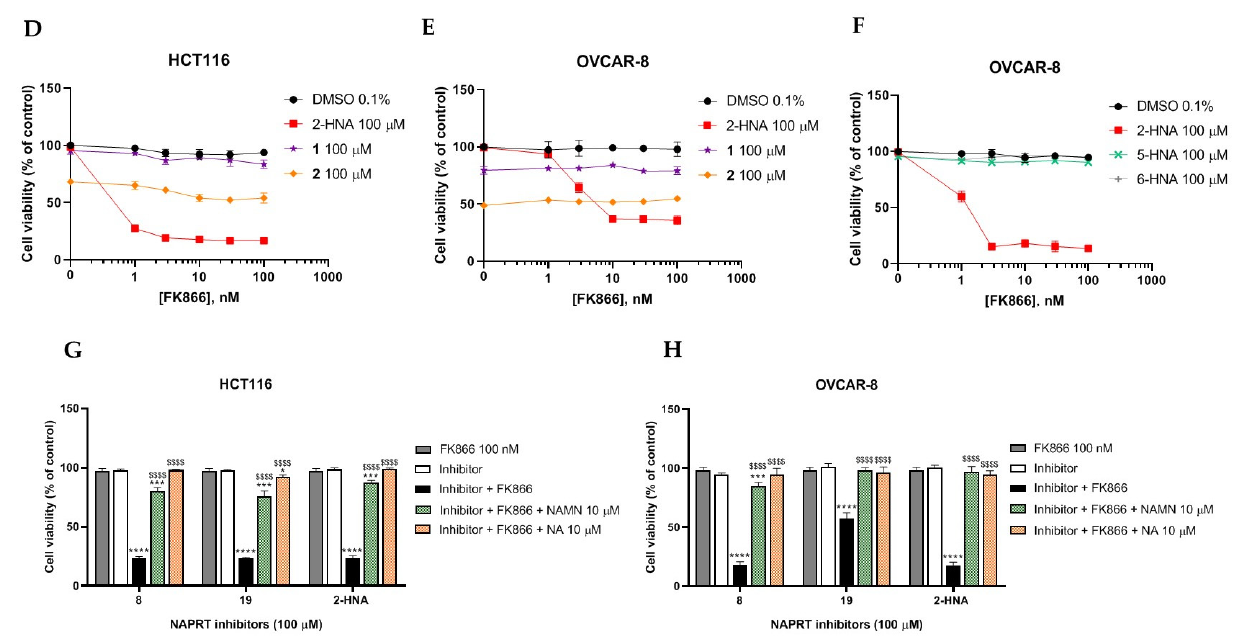
Figure 6. Compound 8 and compound 19 sensitize ovarian and colon cancer cells to FK866 via NAPRT inhibition. ( A – F ) HCT116 and OVCAR-8 were plated in 96-well plates (2 × 10 3 cells/well) and allowed to adhere overnight. The following day, culture media were replaced with new media containing the respective treatments (i.e., with or without FK866 at increasing concentrations from 1 to 100 nM and the putative NAPRT inhibitors, added at 100 µ M final concentration), and the plates were then incubated for 72 h. Afterwards, the cells were imaged using light microscopy as in ( C ), and cell viability was determined using the sulforhodamine B assay. Data are mean ± SD of three experimental replicates. ( G ) and ( H ) The same experimental procedure was employed as in ( A–F ). Single concentrations of the NAPRT inhibitors (100 µM), 100 nM FK866, 10 µM NA, and 10 µM NAMN were added. Data are mean ± SD of 4 experimental replicates. One representative experiment is shown. *, p < 0.05 ; ***, p < 0.001 ; ****, p < 0.0001 ; $$$$, p < 0.0001. The * symbols refer to the